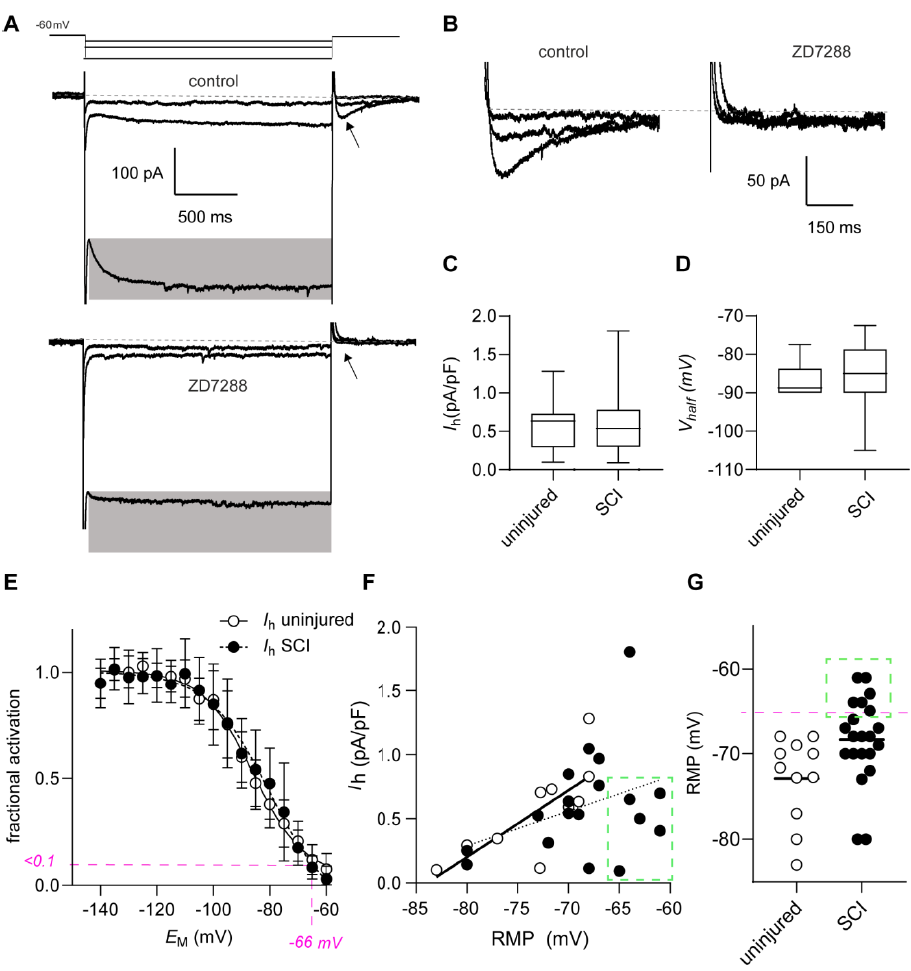
Figure 2. Relation between depolarization and HCN-channel-mediated currents in M1LV neurons. ( A ) Hyperpolarizing voltage steps from a holding potential of − 60 mV elicit slowly activating inward currents (highlighted in gray), which are blocked by ZD7288. Currents selected for graphic display were elicited by hyperpolarizing sweeps to − 135 mV, − 75 mV, and − 65 mV. ( B ) HCN-channel- mediated tail currents elicited by membrane depolarization ( − 60 mV) from hyperpolarized potentials (highlighted in ( A ) by arrowhead). Tail currents are blocked by ZD7288. ( C ) The maximal current ( I h ) density in M1LV neurons does not change significantly after SCI. ( D ) Voltage of half-maximal activation and ( E ) I h fractional activation are not affected by SCI. Pink dotted line highlights voltage of − 66 mV, at which I h activation is negligible (<0.1). ( F ) There is a significant correlation between the RMP and the maximal I h current amplitude in uninjured neurons (solid line shows linear regression). Correlation is not significant after SCI (dotted line shows linear regression). Green inset highlights depolarized RMP and small I h amplitude ( G ). The RMP of some axotomized neurons is considerably depolarized after SCI ( ≥− 66 mV), whereas the I h activation at RMP in these cells is negligible (( E ) pink dotted line), and the maximal I h current amplitude is low ( F